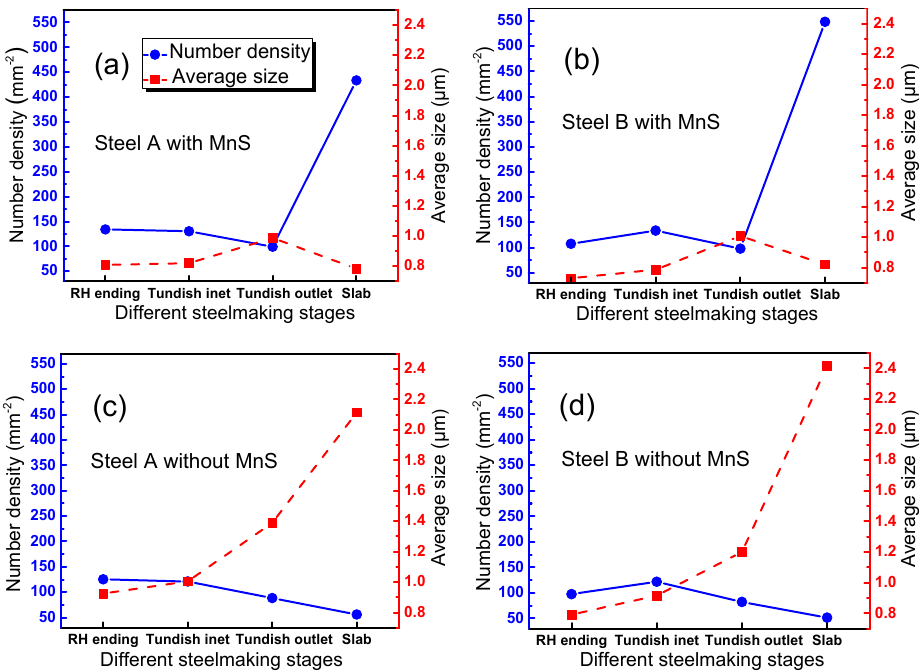
Figure 5. Changes in the number density and average size of total inclusions from RH to slab with MnS for Steels ( a ) A and ( b ) B, without MnS for Steels ( c ) A and ( d ) B.